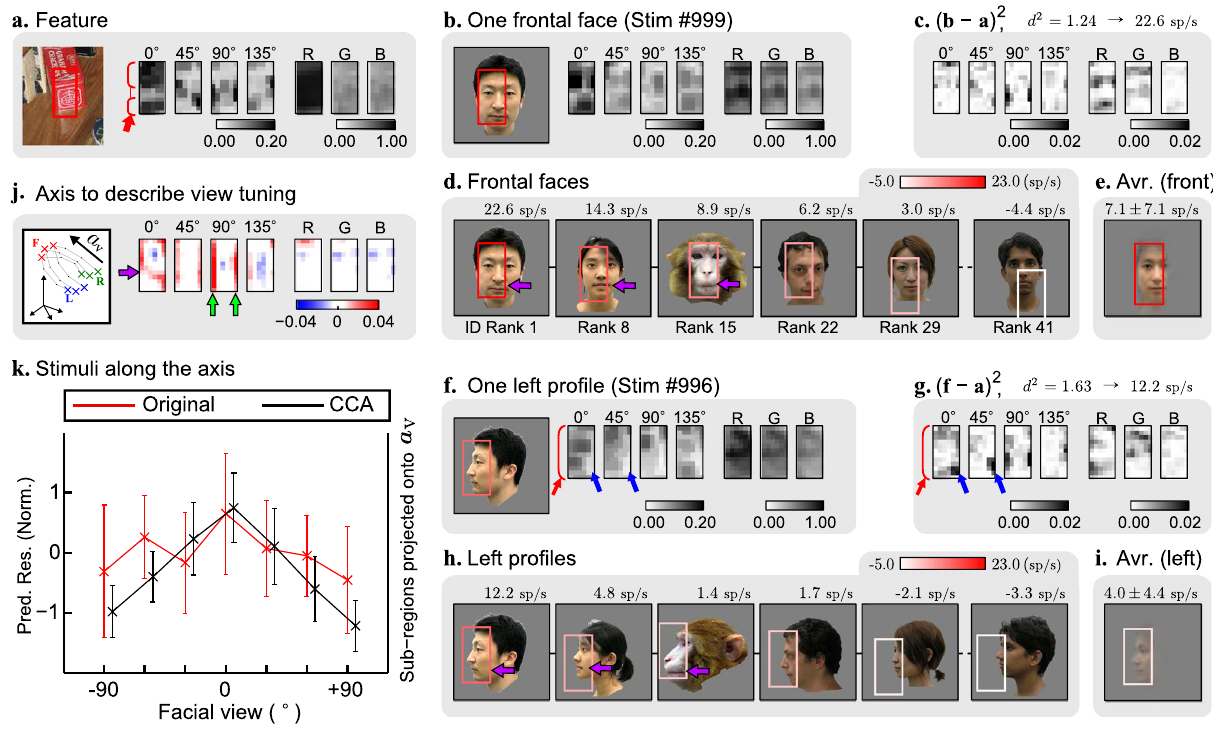
Figure 7. ( A ) The identified visual feature of site S1_a. ( B ) The sub-region (red rectangle) of a front-face with the highest similarity to the feature. ( C ) The response was predicted from the squared distance between the feature ( A ) and the sub-regions ( B ) in local orientation and color components. ( D ) The sub-regions (rectangles) from the other front-faces. Above, the predicted responses for each face. Below, the ranks of faces with respect to the predicted responses to front-faces. ( E ) The weighted average of sub-regions captured from all 41 front-faces (see Supplementary Fig. 5 for the procedure). ( F )–( I ) The same as ( B )–( E ), but with the left profile faces of the same identities. The rotation from front to left view evokes two major changes: (1) the decrease of horizontal components (0°) (red arrows in ( F ) and ( G )), and (2) decrease of orientation components at the lower right 2 corner (blue arrows). These changes caused the squared distance ( d ) to change from 1.24 to 1.63. The sub- region captured from different faces were almost the same regardless of views, although the weighted average image was faint in the left profile because of weaker predicted responses, as shown in ( E ) and ( I ). ( J ) The axis ( a V ) extracted from CCA to visualize how each component changes when the face was rotated from the non- preferred (left and right) to the preferred (front) view. ( K ) Inner products between the sub-regions of faces (n = 41 × 7) and the axis extracted from CCA (black line, right axis) plotted on top of the original view tuning curve (red line, left axis). Error bar, standard deviation across identities. The correlation coefficient between the two lines was 0.212 ( p < 0.001), suggesting that the tuning curve was correctly approximated by using the